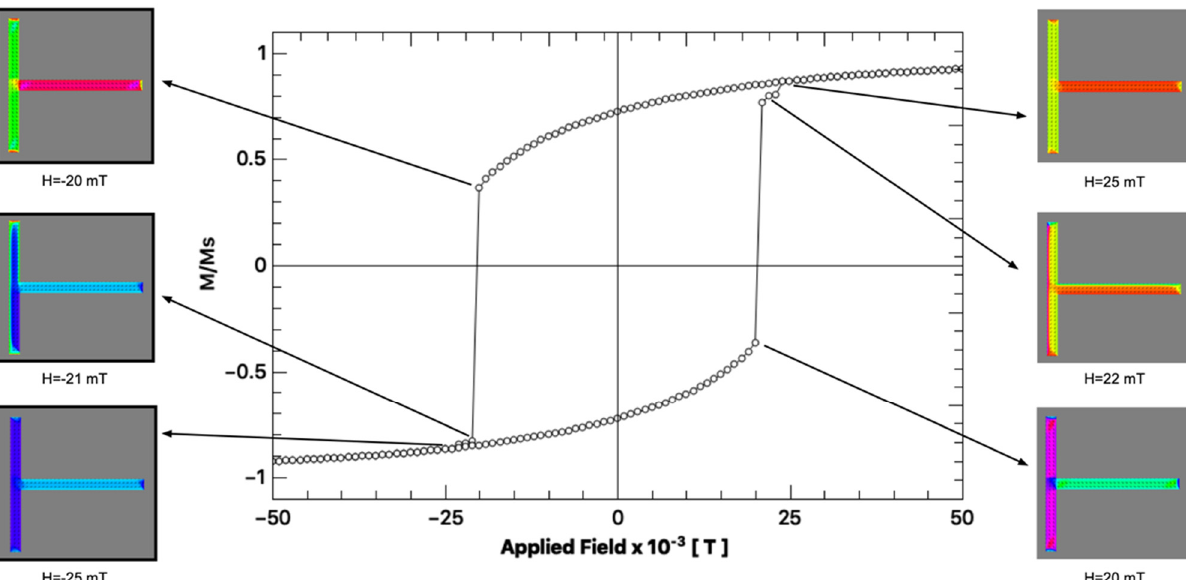
Figure 6. Simulated hysteresis loops a single T-shaped structure with L = 5 µ m. The external field is applied along the [1, 1] direction and the magnetization is the total reduced magnetization along that direction. A sudden jump of the magnetization is observed both around H = − 20 mT and H = 20 mT, the field at which both arms of the structure exhibit magnetization reversal.